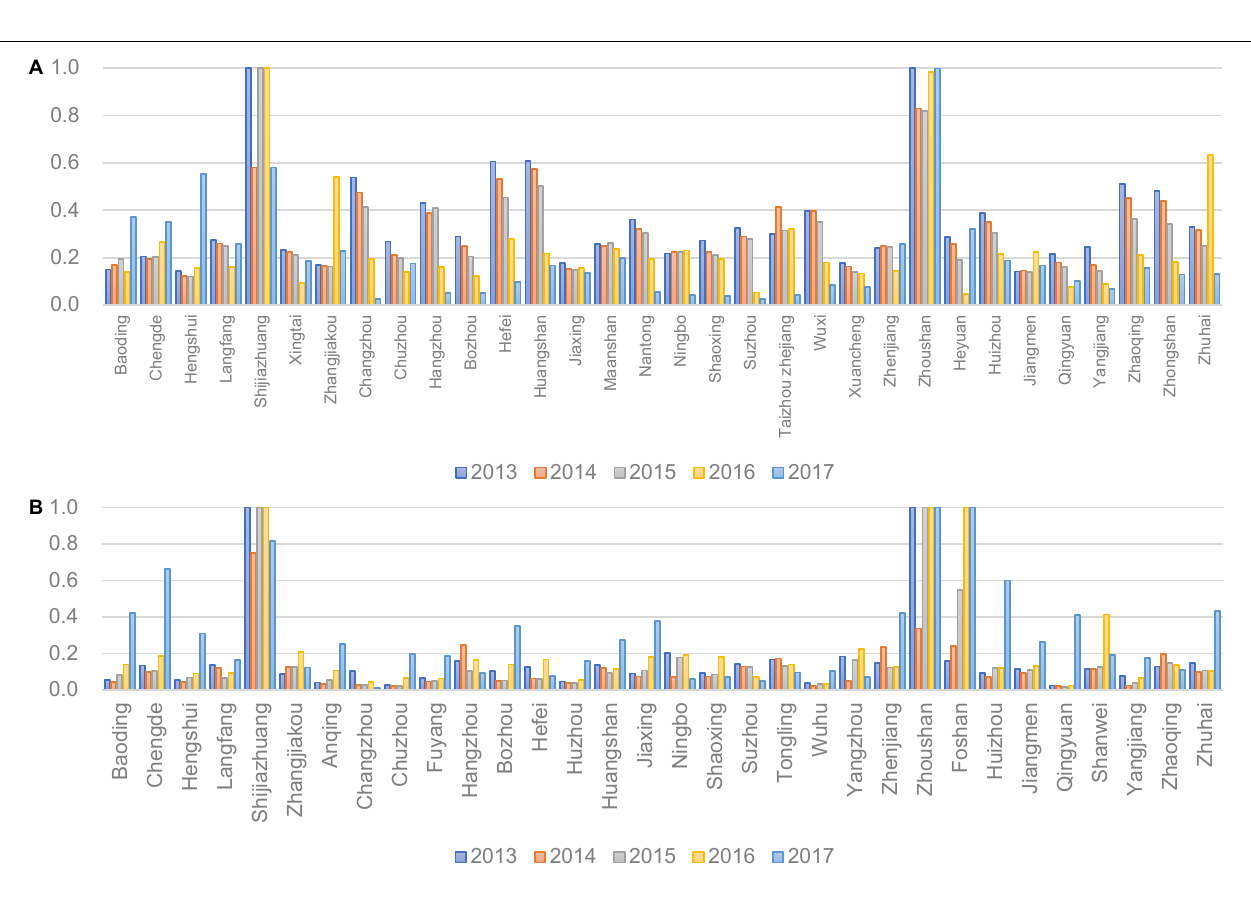
even showing a downward trend. This fully means that the economic development and pollution control of these cities cannot be effectively coordinated